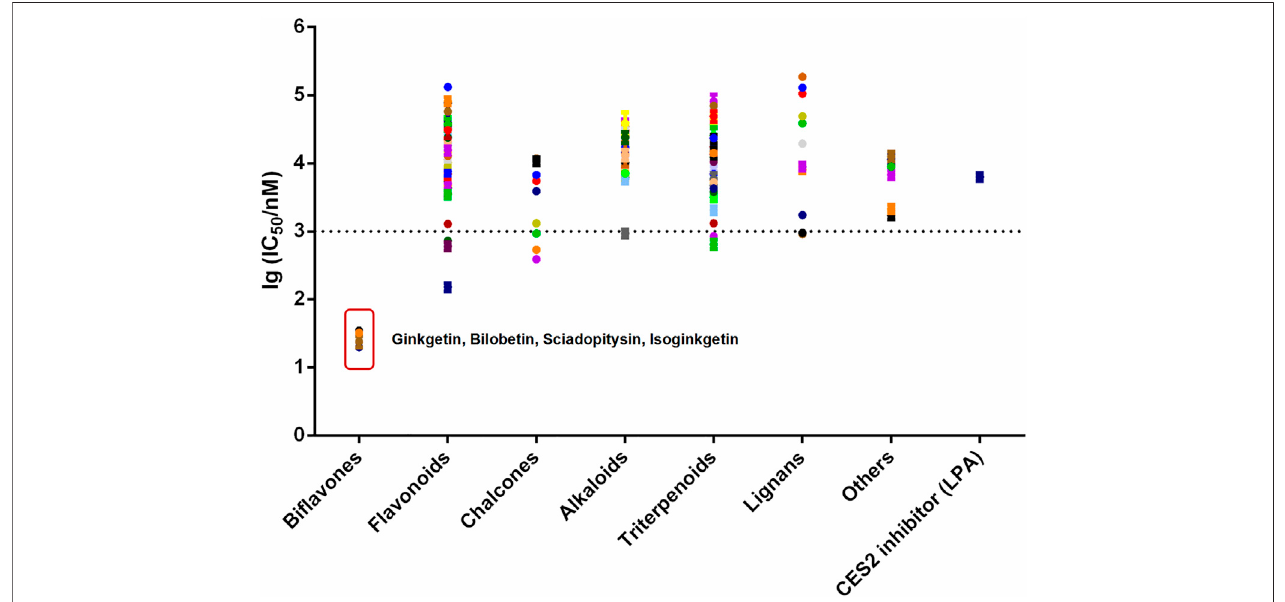
FIGURE1| Thelg(IC 50 /nM)ofmorethan100kindsofnaturalproductsandpositiveinhibitor(LPA)onCES2.Alldatawereshownasmean ± SDoftriplicateassays.